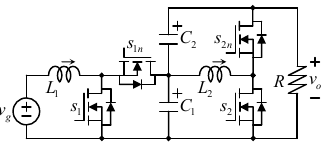
Figure 12. The schematic of the experimental test bench.